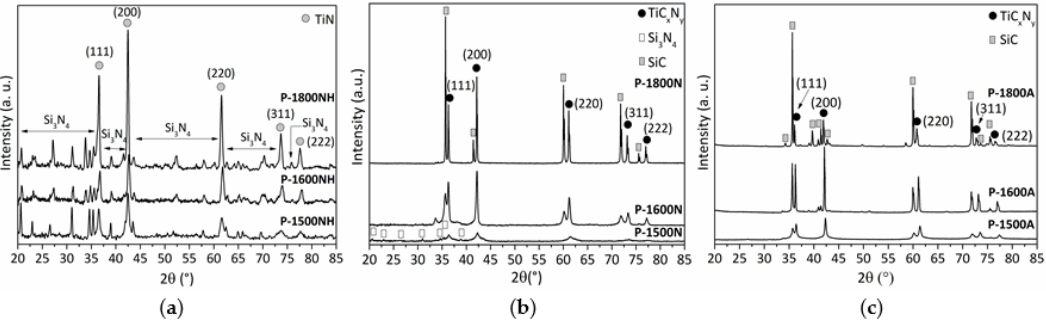
Figure 14. Evolution of the XRD patterns of P-1000NH ( a ), P-1000N ( b ) and P-1000A ( c ) samples in the temperature range 1500–1800 °C.